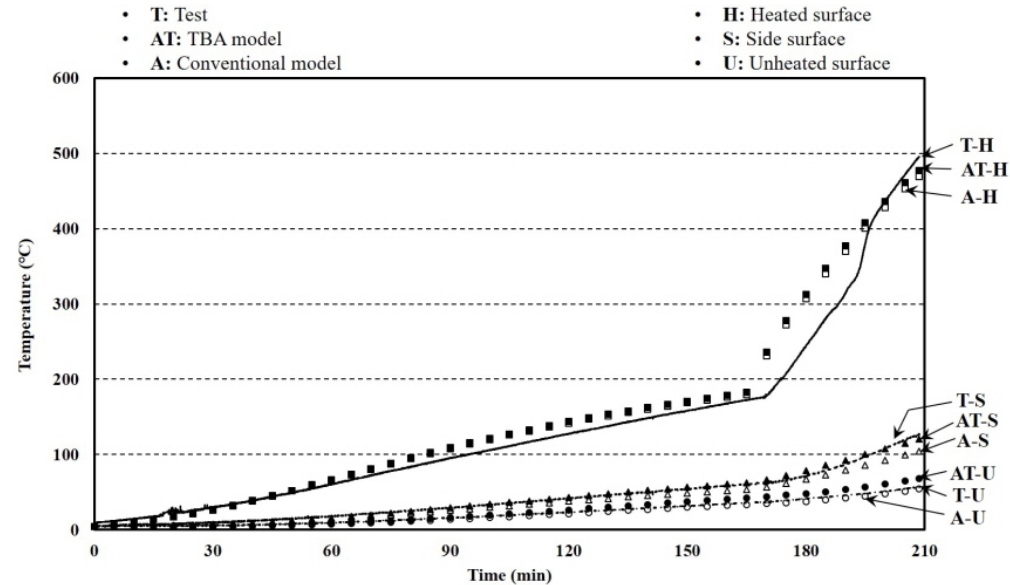
Figure 15. Temperature results of larger furnace tests and FEA with a 50-mm thickness.